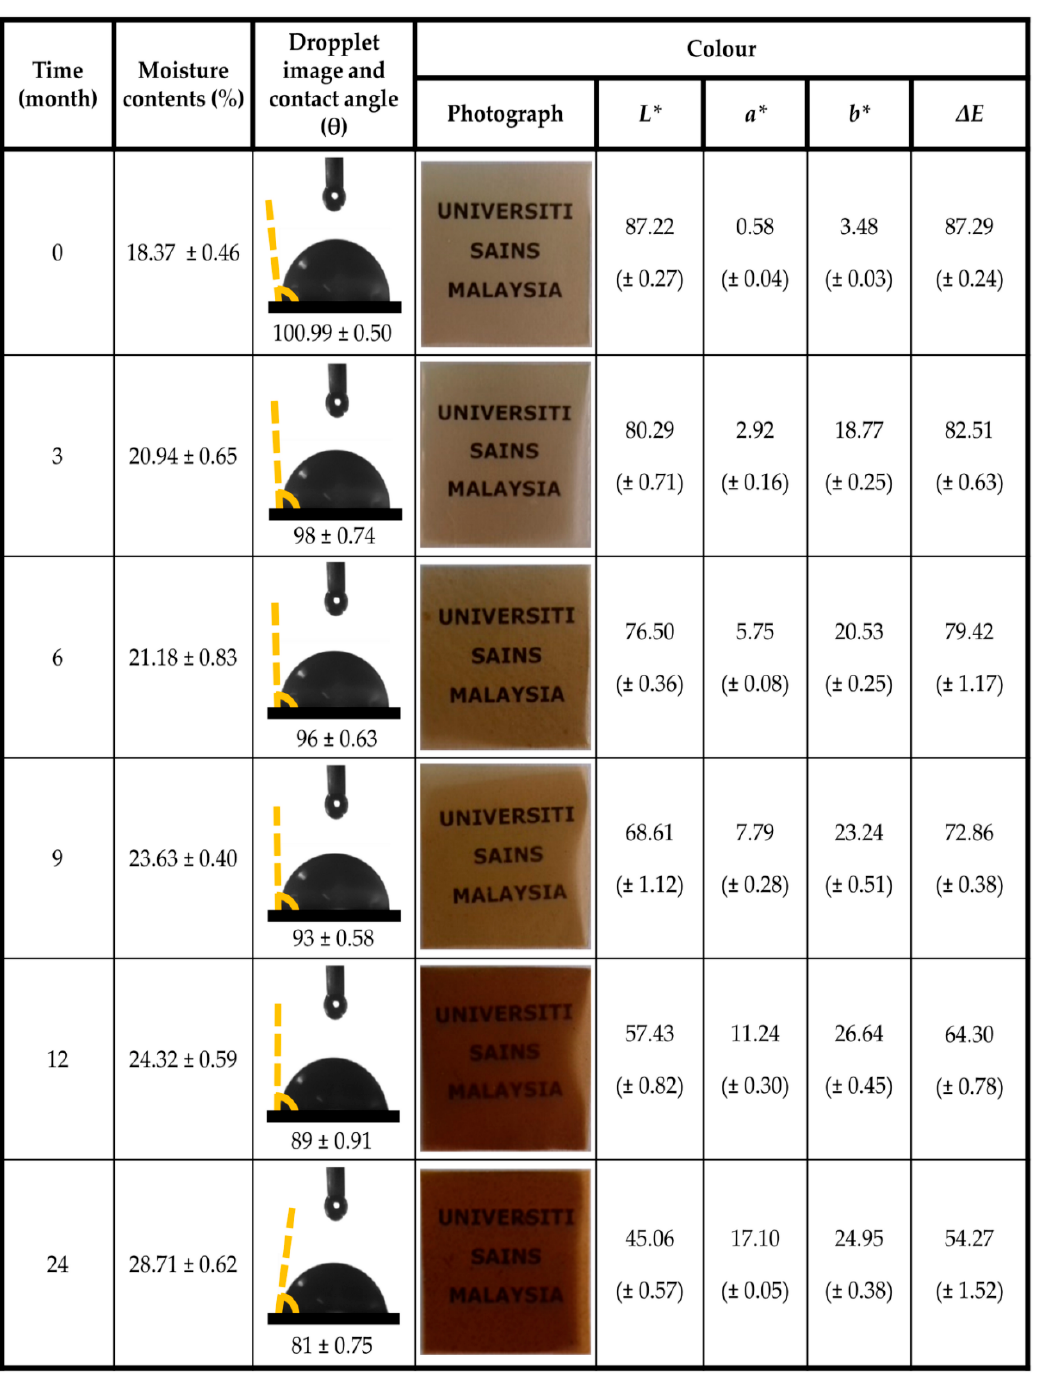
Figure 6. Moisture content, contact angle, and color properties of seaweed–neem films at different doses of radiation. The effect of storage time on the properties of the ISN films as packaging material Table 1. Effect of storage period on tensile properties of the packaging were evaluated at ambient conditions (25 °C with 50% RH). The effect of storage time on the tensile properties of the packaging film such as tensile strength (TS), tensile modulus (TM), and elongation at break (EAB) were shown in Table 1.